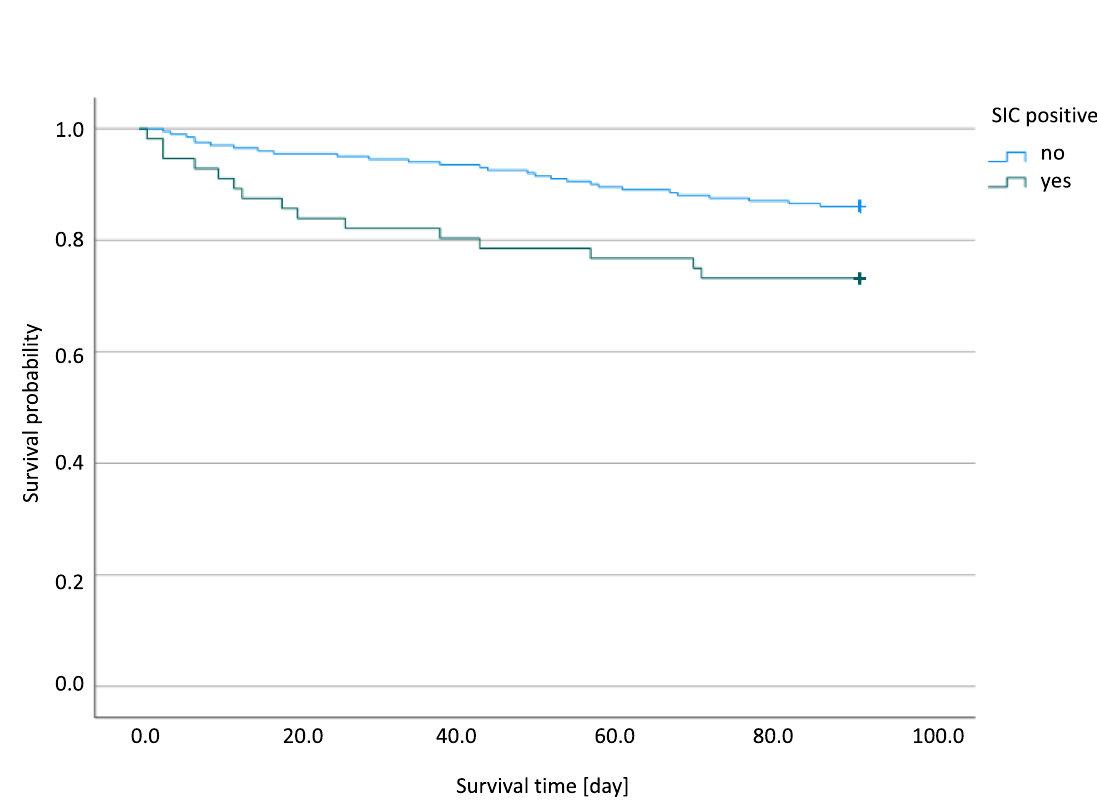
0.014) Blue line: SIC negative patients. Green line: =